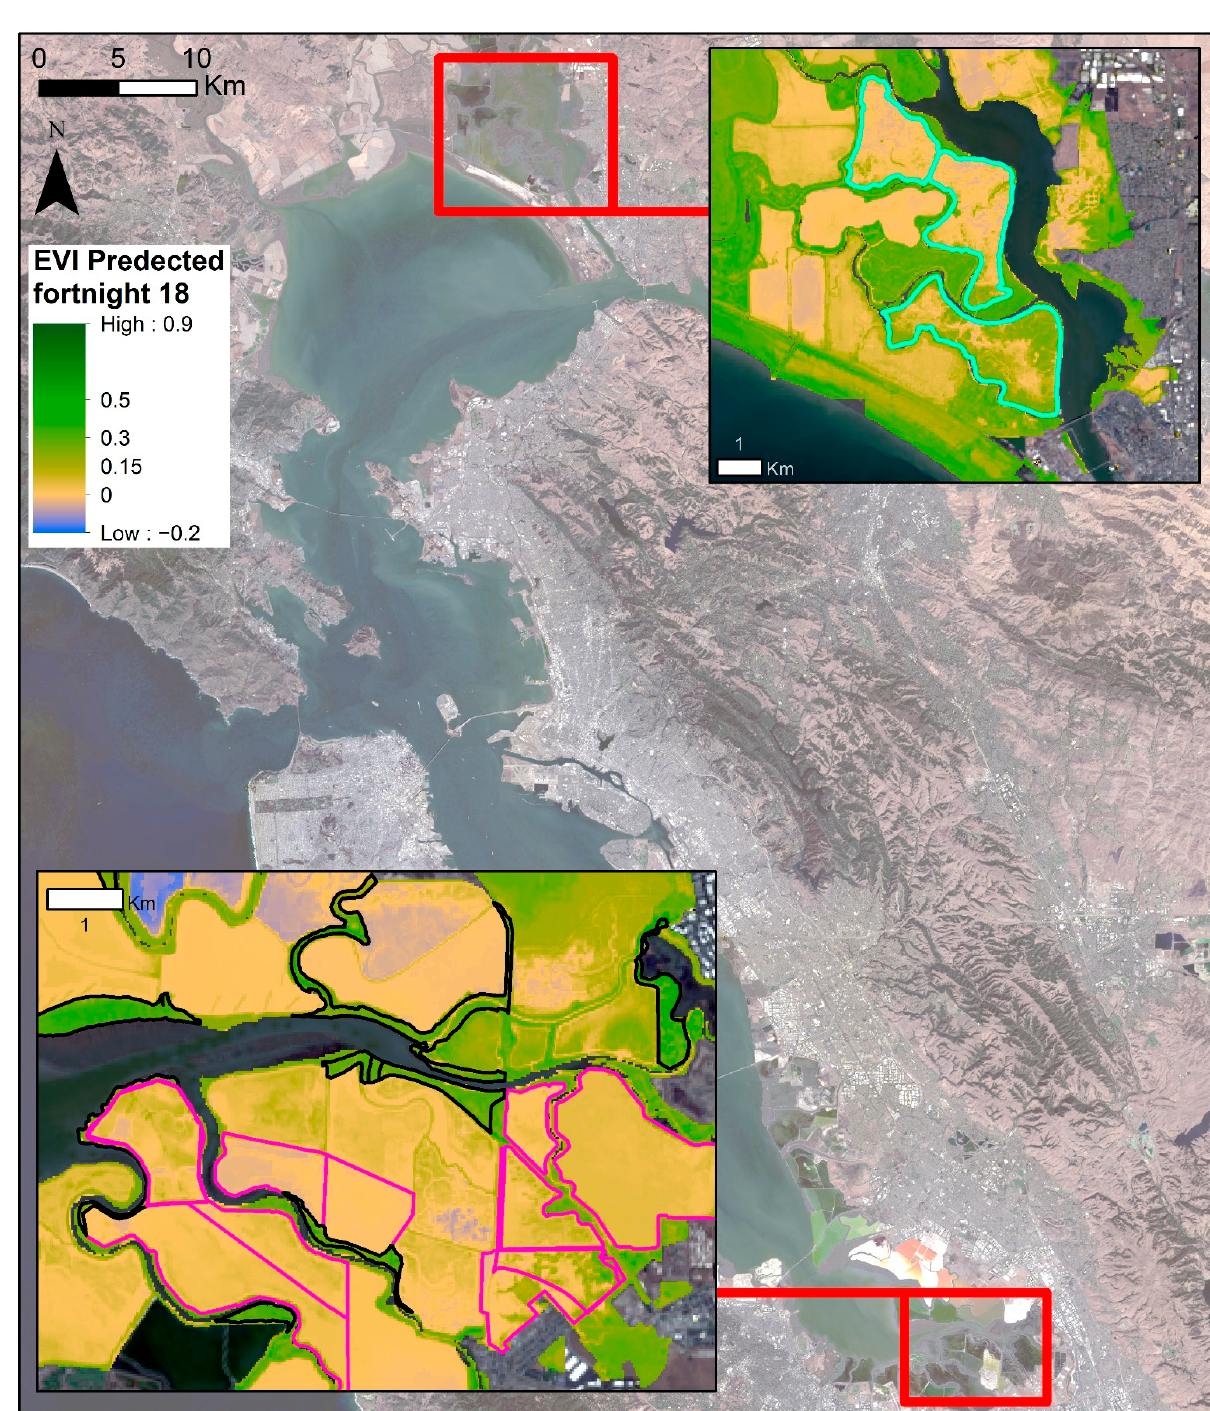
Figure A3. Zoomed in wetland areas within the South Bay and the Napa-Sonoma Ponds 3, 4, 5. Areas outlined in cyan are the Napa-Sonoma Ponds 3, 4, 5. The areas outlined in pink are restored wetland areas, and areas outlined in black are the historical wetland areas that have not been significantly altered. The blue to green shading indicates the predicted EVI for the fortnight starting 2 September 2018, with blue having the lowest plant signal and darker green the highest. Basemap: Landsat 8, U.S. Geological Survey.